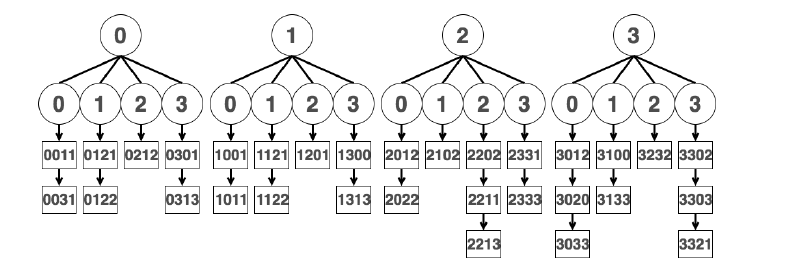
Figure 2: Radix-Tree-List structure with b = 4 and l = 2 Table 2: Verifying experimentally the optimal